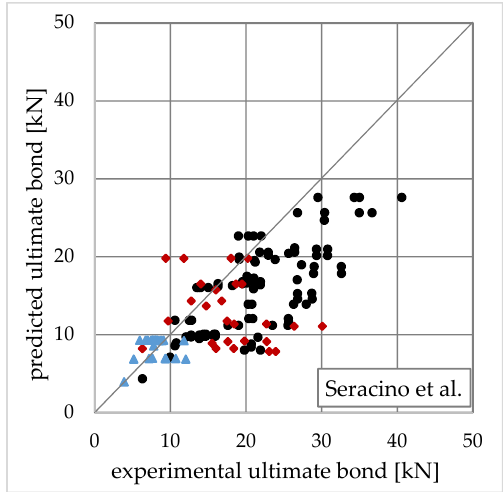
Figure 17. Test vs. predicted bond force using the DeLorenzis et al. model [29]. Appl. Sci. 2020 , 10 , 8593